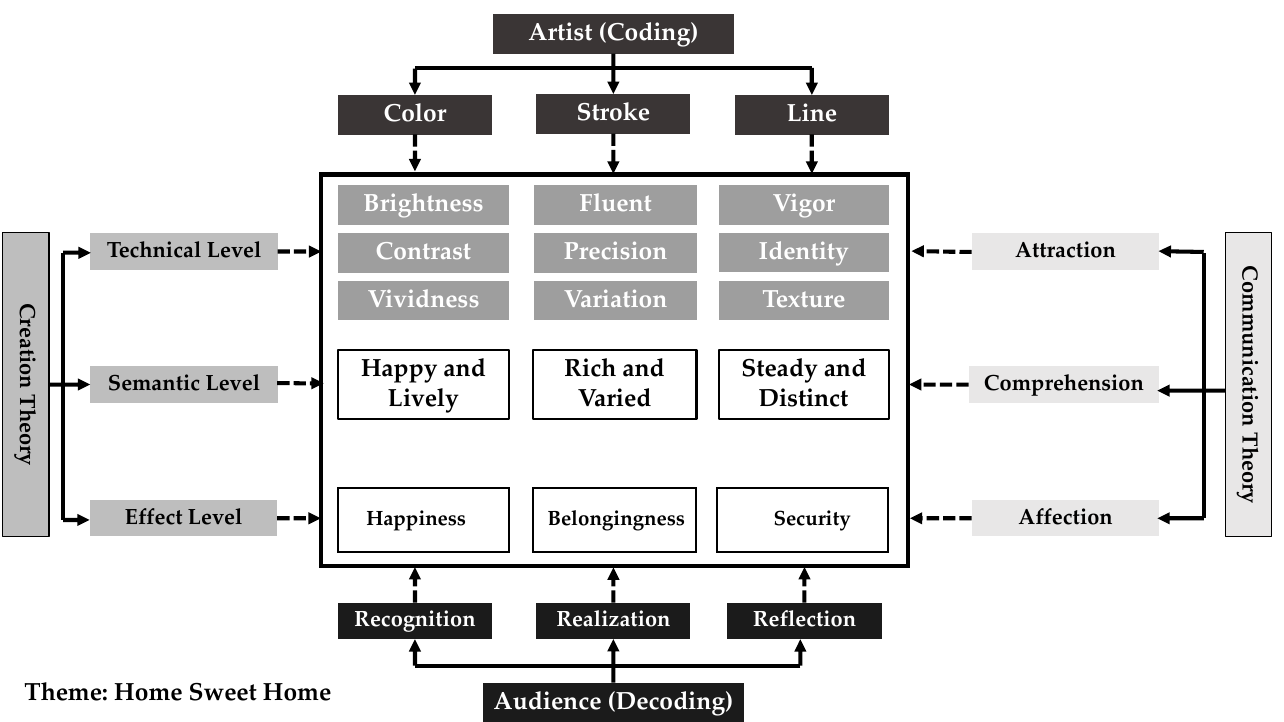
Figure 3. Communication matrix for evaluating artistic style transfer on Home Sweet Home.